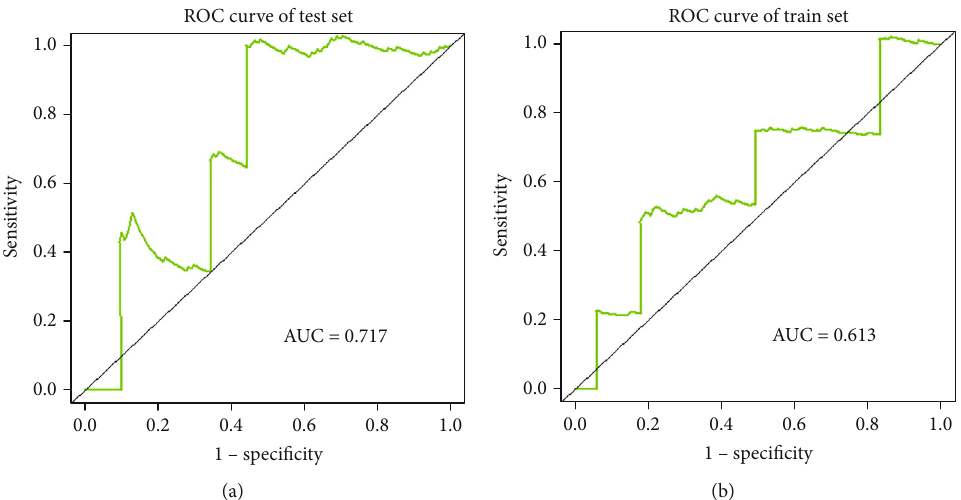
Figure 7: The time-dependent receiver operating characteristic (ROC) analysis. The AUC (area under ROC) score for the training dataset was 0.842, indicating the better performance of survival prediction in the training